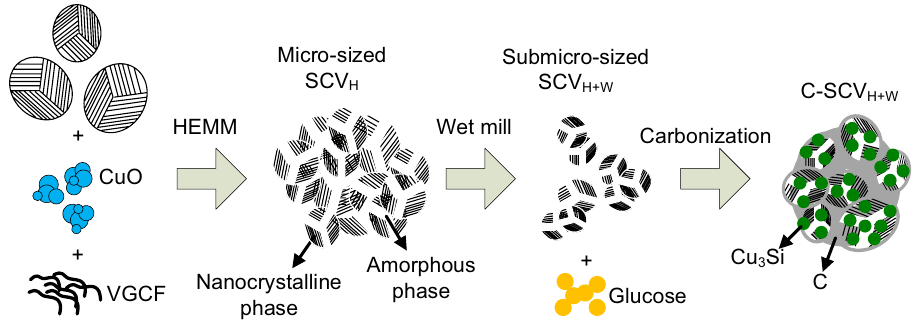
Figure 1. Schematic illustration of the synthesis for Si/Cu 3 Si-based composite